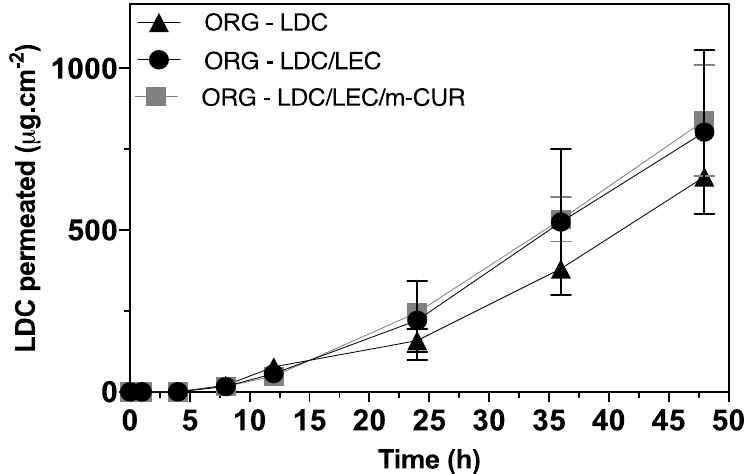
Figure 5. Permeation profiles of lidocaine hydrochloride (LDC) from ORG-LDC, ORG-LDC/LEC and ORG-LDC/LEC/m-CUR across the Strat-M ® membrane. Data expressed as mean ± standard deviation, n = 6/experiment.